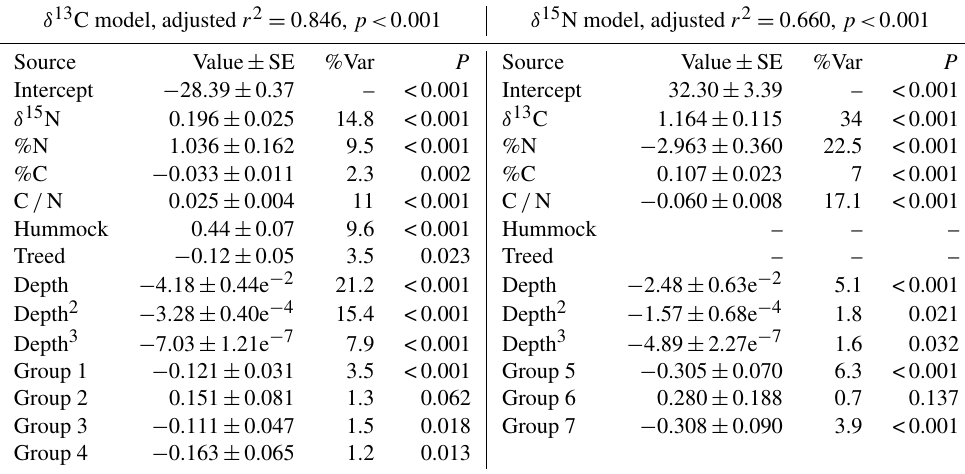
group, the first plots listed have the given value, the second plots listed (after vs.) have the negative of the given value. δ 13 C model, adjusted r 2 = 0 . 846, p< 0 .